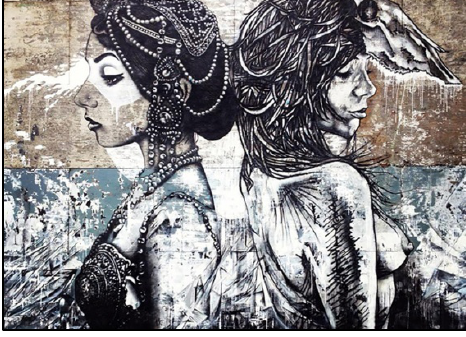
Figure6. Christina Angelina, a Venice-based multi-media artist (Nastasijevic,